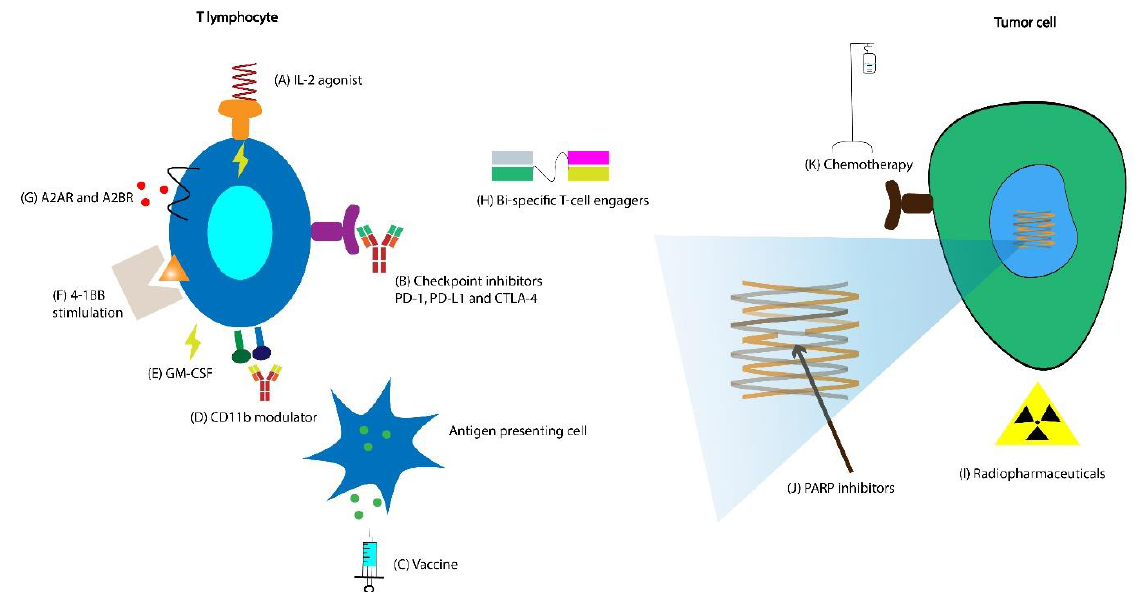
Figure 4. ( A ) Bempegaldesleukin is an interleukin (IL)-2 agonist currently being tested in combination with avelumab. ( B ) Multiple new checkpoint inhibitors (CPIs) are in clinical trials in combination with other agents. ( C ) Currently, there are DNA-, viral vector-, and mRNA-based vaccines in combination with checkpoint inhibitors in clinical trials in mCRPC. ( D ) GB1275 is a CD11b agonist in clinical trials in combination with CPI. ( E ) Granulocyte-macrophage colony-stimulating factor (GM-CSF) is used in combination with vaccines to augment immunological response (NCT04090528). ( F ) 4-1BB stim- ulation has been employed extensively in chimeric antigen receptor (CAR) T cell therapies, and utomilumab, a monoclonal agonist antibody that binds to the 4-1BB is currently in clinical trials for patients with mCRPC. ( G ) Currently, there are four clinical trials combining adenosine receptor antagonists with checkpoint inhibitors in patients with mCRPC. ( H ) After their success in acute lymphoblastic leukemia (ALL) and diffuse large B-cell leukemia (DLBCL), cellular therapies such as CAR T cell and bi-specific T-cell engagers are being studied extensively in clinical trials in numerous solid malignancies, including prostate cancer. ( I ) There are two clinical trials combining checkpoint inhibitor therapy with radiopharmaceutical Lu 177- PSMA-617, which is a β emitting isotope of lutetium attached to prostate-specific membrane antigen (PSMA). ( J ) While poly ADP ribose polymerase (PARP) inhibitors have already demonstrated efficacy in patients with homologous recombination deficiency (HRD), clinical trials are currently ongoing in combination with agents such as radiopharmaceuticals, CPIs, and chemotherapy evaluating whether they are effective in patients without HRD. ( K ) Chemotherapeutic agents have potential synergy with checkpoint inhibitors, and clinical trials to test this hypothesis in patients with mCRPC are currently